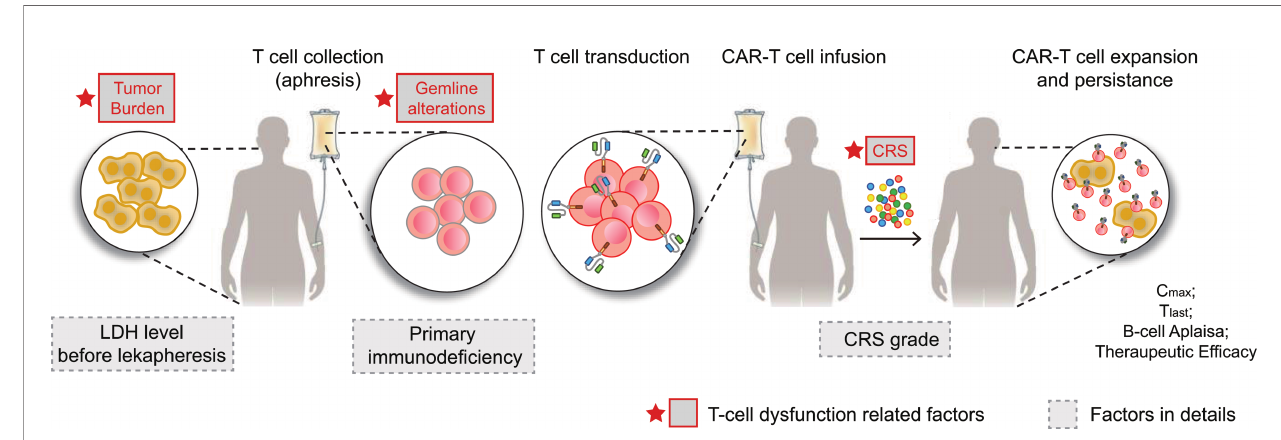
FIGURE 5 | CAR-T cell therapy and T-cell dysfunction-related factors. CAR-T therapy involves separating a patient ’ s T cells via apheresis and then genetically engineering the cells to produce receptors on their surfaces, called CARs. CARs are fusion proteins of an antigen-recognition domain from a monoclonal antibody and one or more T-cell receptors. They allow T cells to recognize and attach to speci fi c proteins, namely tumor antigens. T cells counts are expanded to hundreds of millions, after which the cells are then infused back into the patient, selectively destroying chemotherapy-resistant cancer cells. Patients receiving CAR-T are at risk for developing CRS, an in fl ammatory response that occurs secondary to cytokine release by infused CAR-T cells. CRS is characterized by fevers, hypotension, tachycardia, elevated in fl ammatory marker levels, and end-organ damage, including acute kidney injury and neurotoxicity. In summary, tumor burden (LDH level before leukapheresis), germline alterations (T cell-related PIDs), and CRS (CRS grade) were factors associated with CAR T-cell function. CAR, chimeric antigen receptor; CRS, cytokine release syndrome; LDH, lactate